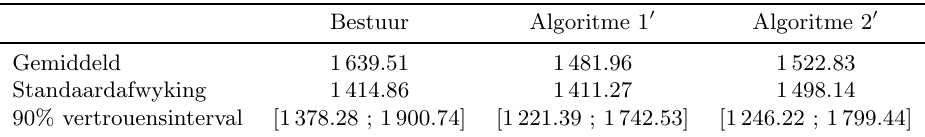
Tabel 3: Gemiddelde verliese (in rand) met D ( P i , t )